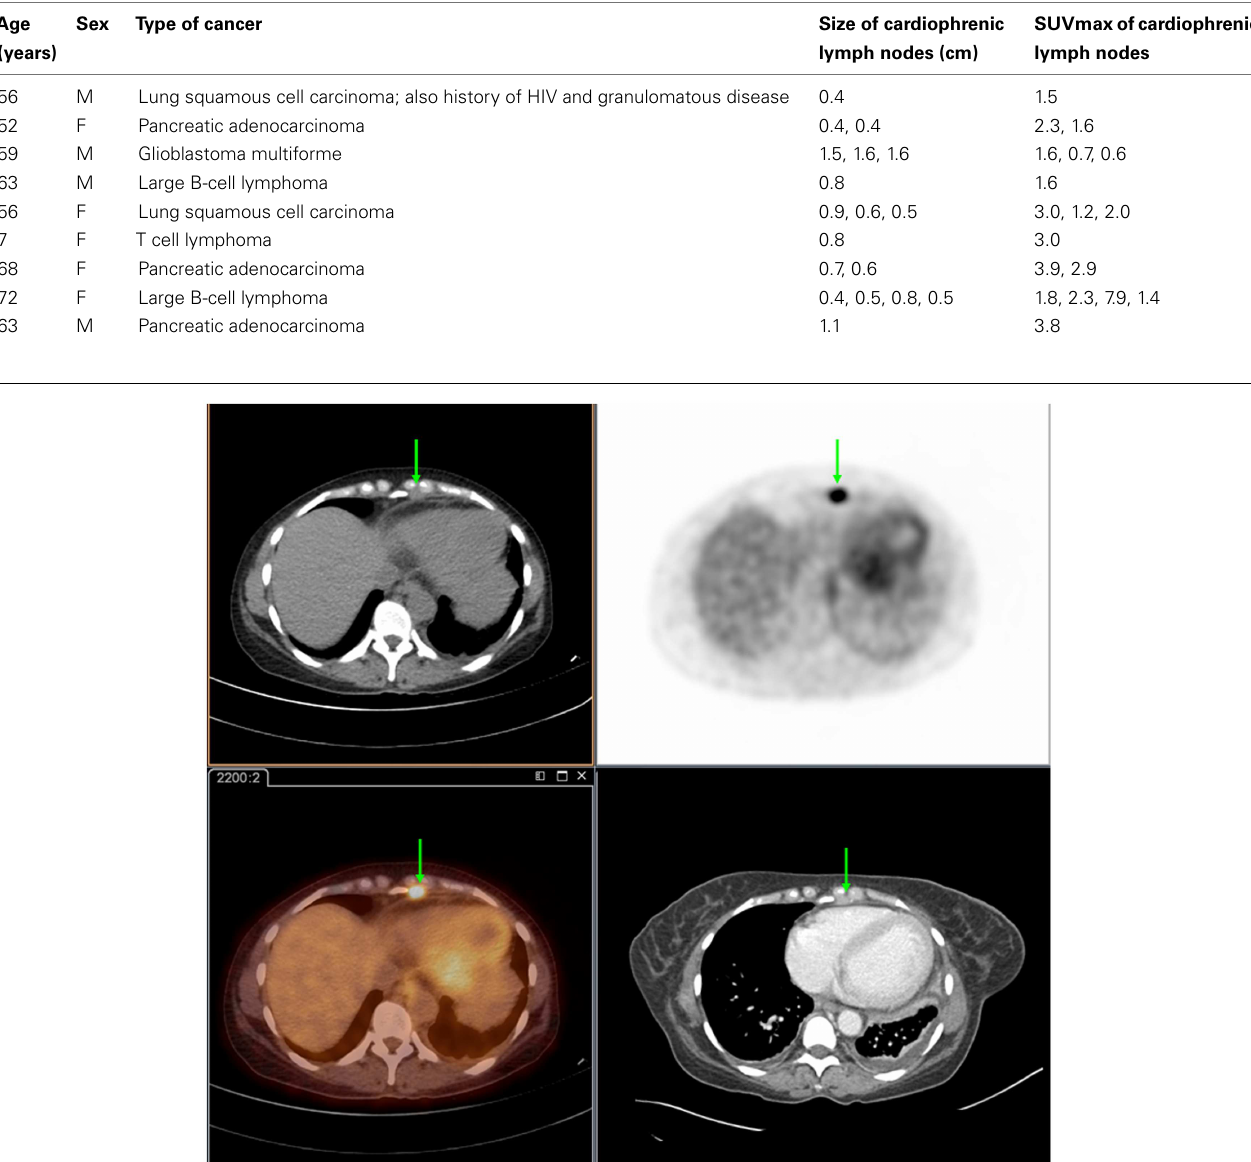
FIGURE 1 | Seventy-two year-old female presenting with metastatic pancreatic adenocarcinoma . PET/CT demonstrates an FDG-avid cardiophrenic lymph node on non-contrast CT (top left), PET (top right), and